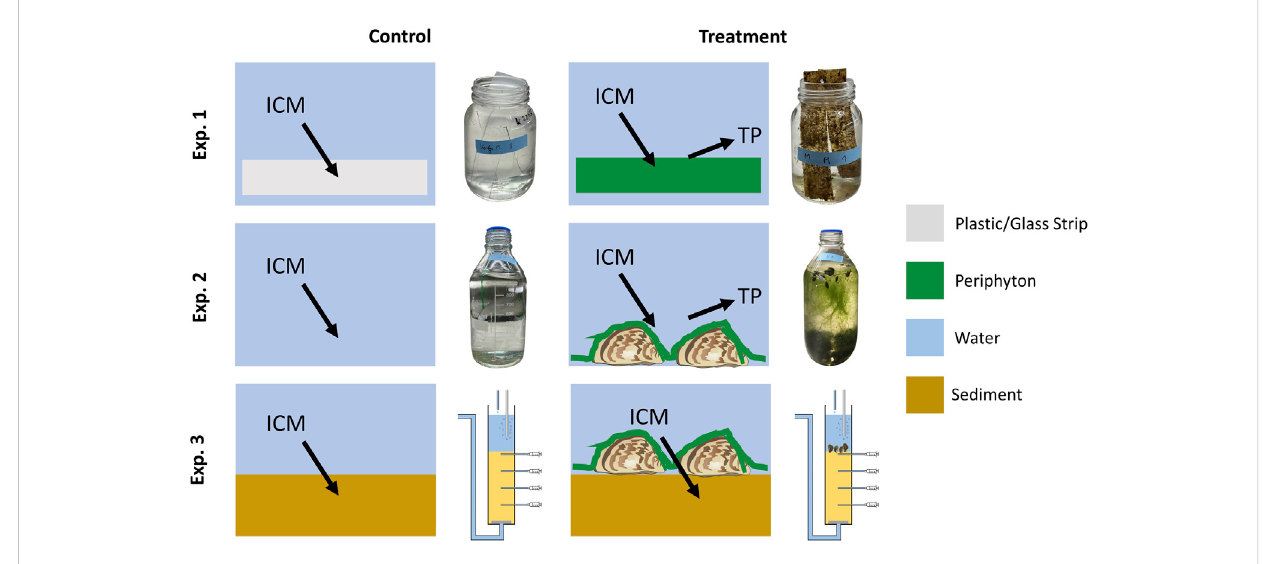
FIGURE 1 Experimental setup for testing the effect of periphyton on the transformation of iodinated contrast media (ICM) into transformation products (TP). Batch cultures were used in experiment (Exp.) 1 with periphyton on plastic or glass strips, or with periphyton on quagga mussels in Exp. 2 while a column experimentwithmusselsandperiphyton onsedimentwasappliedinExp.3.PicturesofvesselsinExp.1and2show controlsandtreatments after30 days incubation time, while the fl ow-through column setup is shown for Exp. 3. In all experiments, we used four replicates for each of the controls and